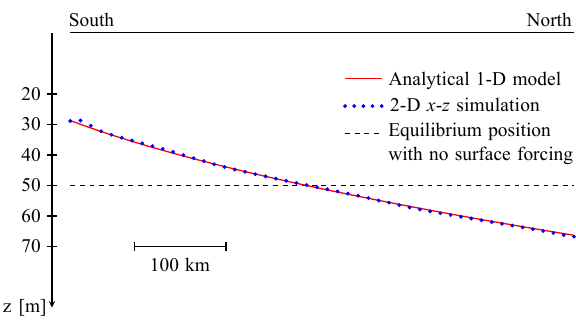
Figure 12. Comparison between the analytical steady-state thermo- cline profile using the 1-D two-layer approximation and the 2-D x - z simulation, under a constant wind stress. The dashed line represents the thermocline position without wind